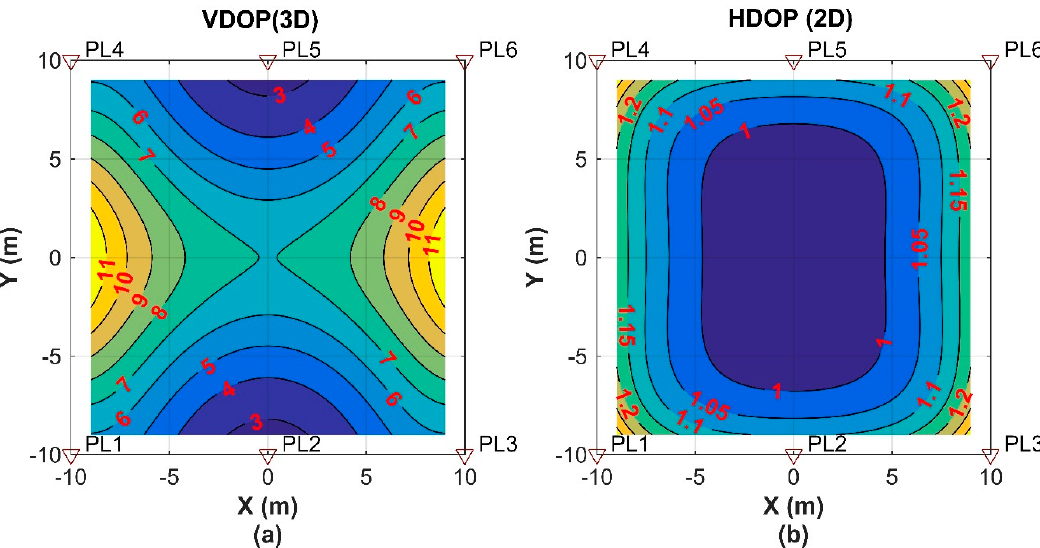
Figure 6. VDOP (vertical dilution of precision) and HDOP (horizontal dilution of precision) in 2D mode of the pseudolite layout. ( a ): VDOP for 3D positioning; ( b ): HDOP for 2D positioning implemented in this paper.